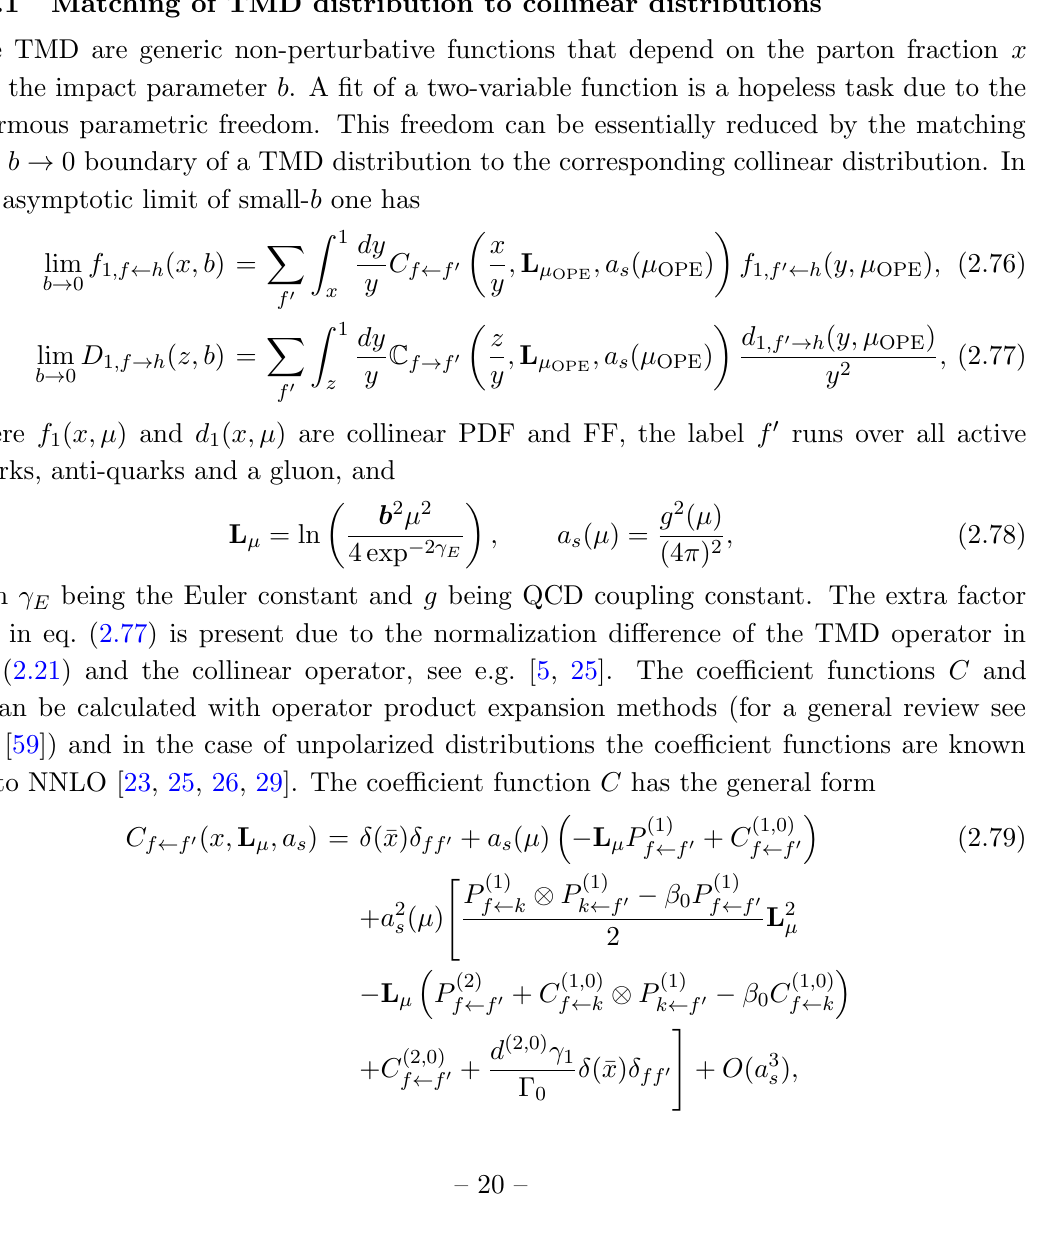
-order of anomalous dimensions with a k +1 s